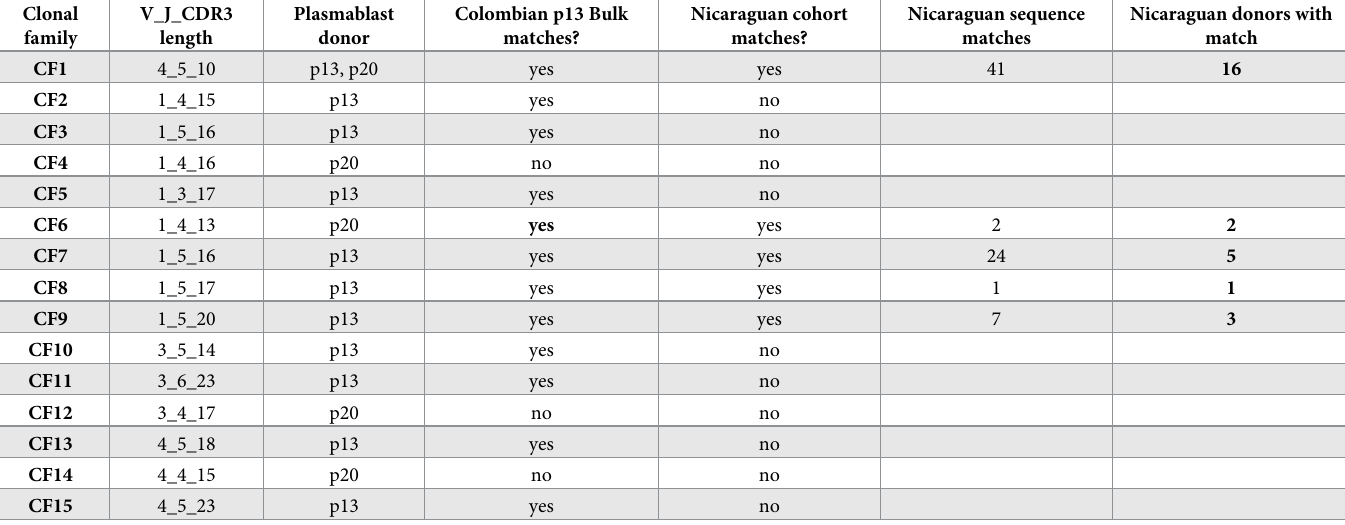
Table 3. Dengue convergence to plasmablast clonal